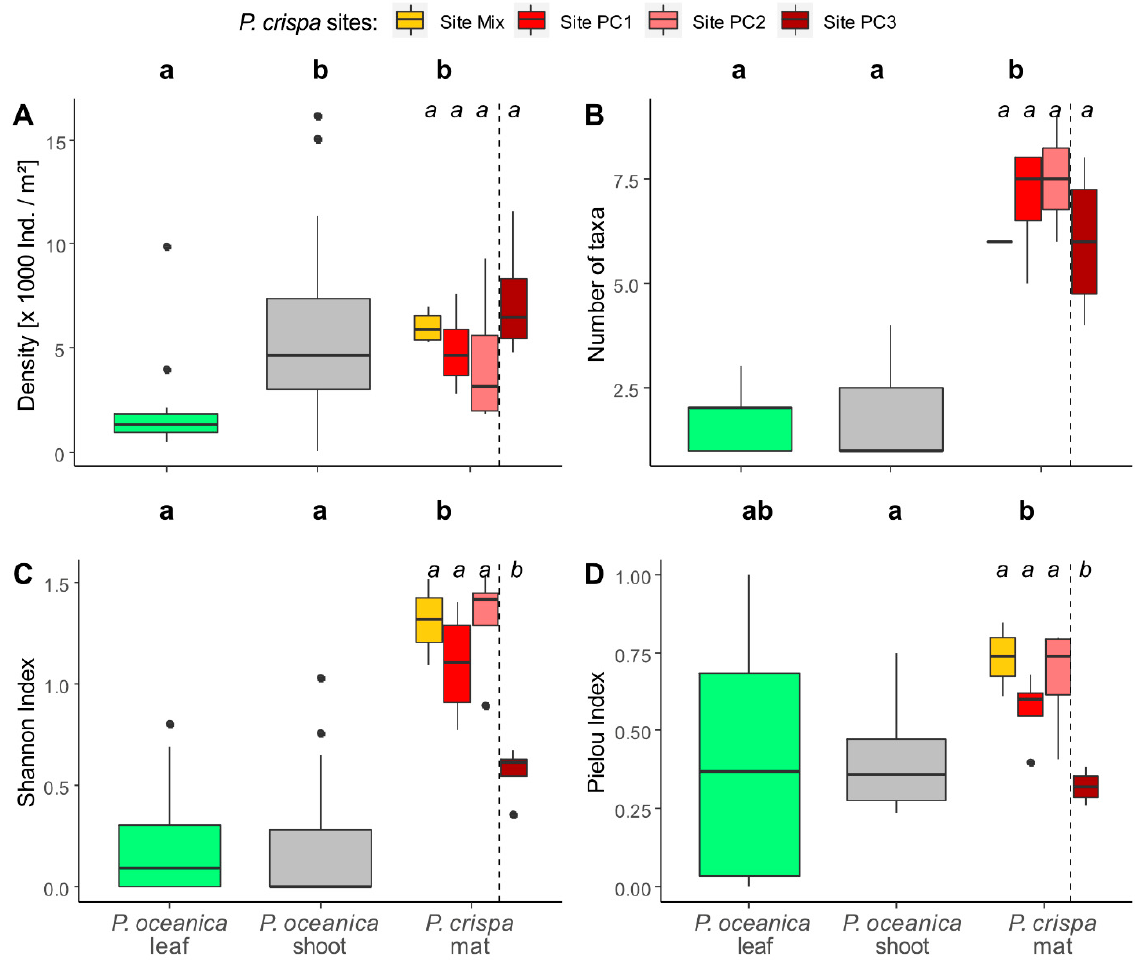
Figure 3. ( A ) Total numbers of identified species per site, ( B ) mean densities of serpulids per m 2 substrate per site, ( C ) Shannon diversity index and ( D ) Pielou evenness index reported for the investigated P. crispa (red) sites in comparison to P. oceanica leaves (green) and shoots (grey). Letters a and b indicate the results of pairwise Wilcoxon–Mann–Whitney tests performed for comparison among habitats in northern sites (excluding PC3; bold letters) and among all P. crispa sites. Black dots resemble outliers.